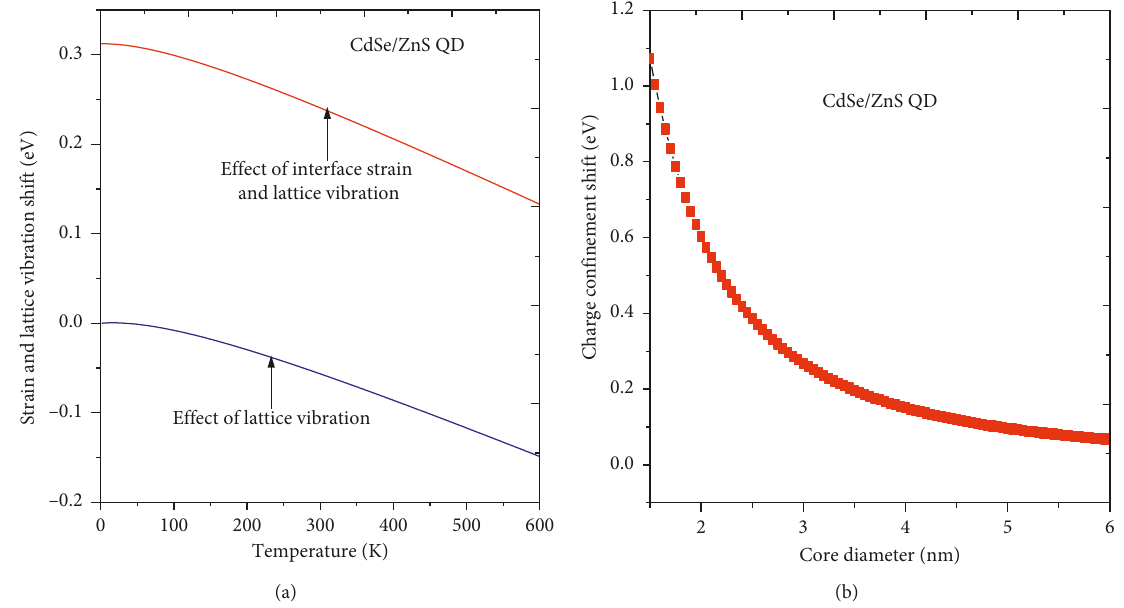
Figure 7: Effects of interface strain and electron-phonon interactions (a) and charge confinement effects (b) on band gap decrease of CdSe/ ZnS core/shell QDs,